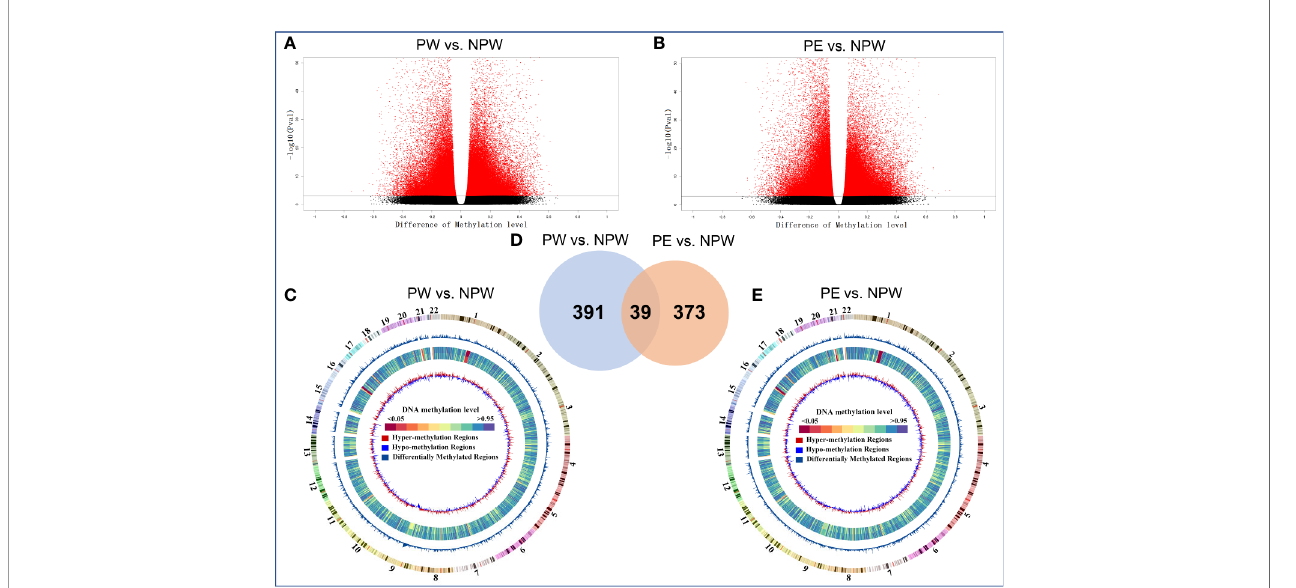
FIGURE 3 | Whole-genome DNA methylation pro fi les of the PW and PE groups. (A, B) Methylated sites of PW and PE groups in a volcano plot. Most detected sites were methylated in immune cells in the PW and PE groups compared with the NPW group. Red and black plots represent signi fi cantly differentially and not differentially methylated sites, respectively. The dots on the left and right sides of each volcano represent hypo- and hypermethylation levels. (C, E) Circus plot of methylation levels in the PW and PE groups compared with the NPW group. There are fi ve circles from the outer side to the inner side, which represent the methylation in the chromosome, DMR, mean methylation levels in the NPW group and PW group, and hypo- and hypermethylation distribution in the PW group compared with the NPW group. Red represents the hypomethylated region, and blue represents the hypermethylated region. (A, C) PW vs . NPW. (B, E) PE vs . NPW. P < 0.05. (D) The 430 DMGs that occurred after normal pregnancy are shown in blue (PW vs . NPW), and the 412 DMGs after PE are shown in yellow (PE vs . NPW). A total of 39 common genes were methylated after normal pregnancy and PE and are shown in the blue-yellow overlap. (A) PW vs . NPW. (B) PE vs . NPW. P <